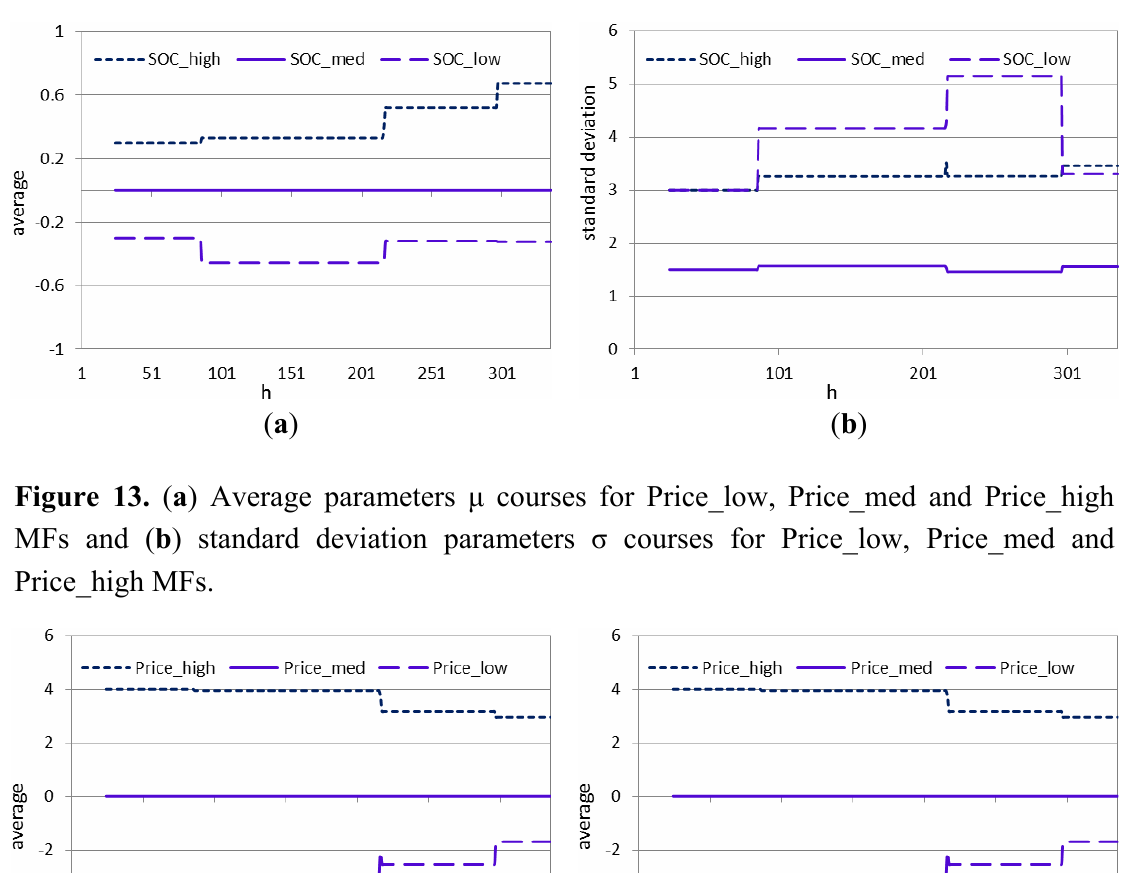
Figure 12. ( a ) Average parameters μ behaviour for SOC_low, SOC_med and SOC_high MFs and ( b ) standard deviation parameters σ courses for SOC_low, SOC_med and SOC_high MFs.